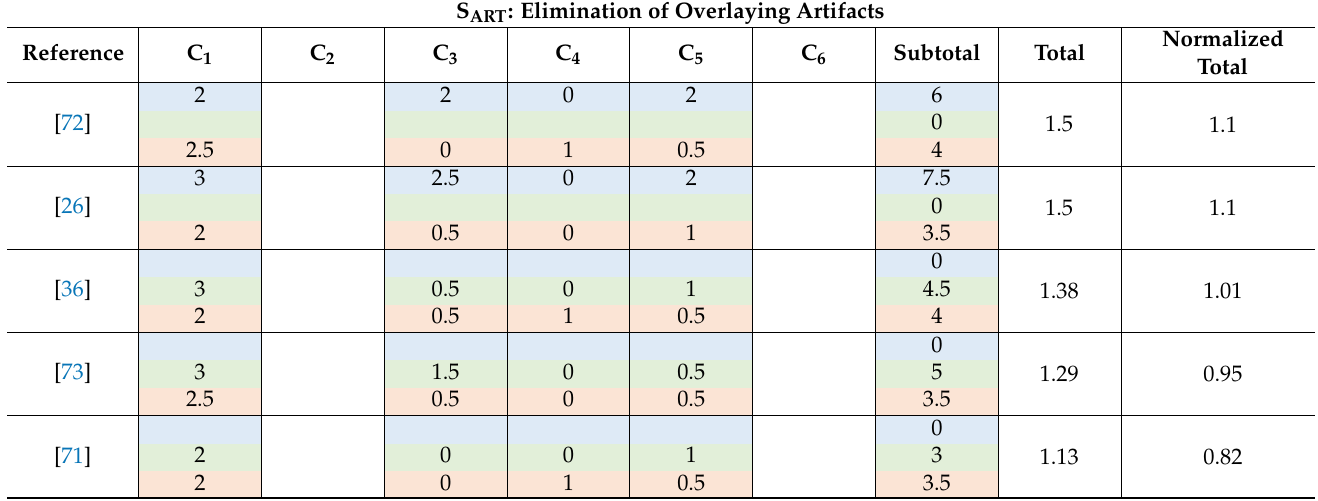
Table A3. Analytical ratings for all studies included in S ART. The color in the table rows indicates the category of experiments as follows: numerical experiments , experiments with phantoms , and experiments with humans in vivo . The columns corresponding to evaluation criteria that were not applicable to this subgroup were left empty.